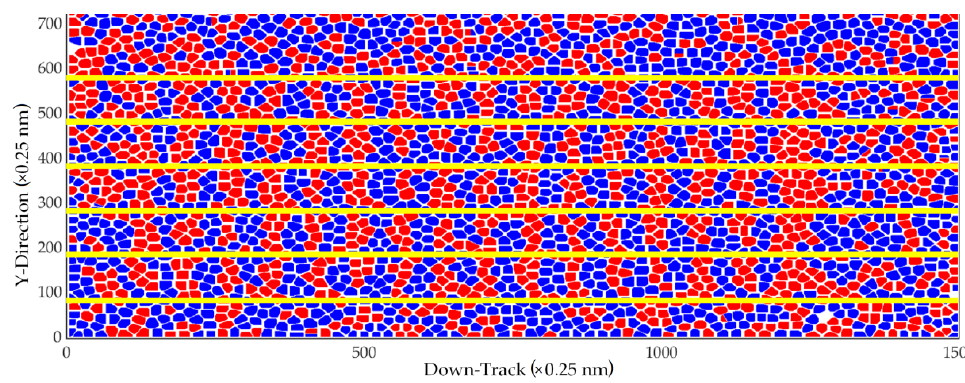
Figure 2. Magnetic footprints of 9 nm bit lengths with a track width of 16.5 nm.